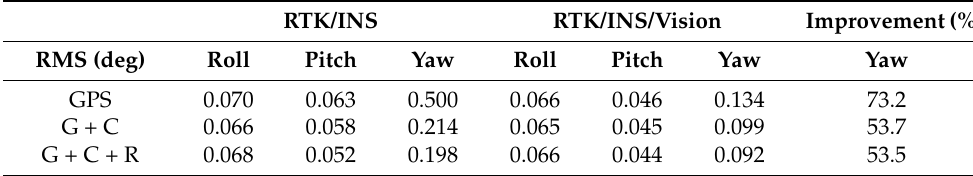
Table 4. RMS of the attitude error of the tightly coupled RTK/INS and RTK/INS/Vision integration for the GPS, GPS + BDS (G+C), and GPS + BDS + GLONASS (G+C+R). RTK/INS RTK/INS/Vision Improvement (%) RMS (deg) Roll Pitch Yaw Roll Pitch Yaw Yaw GPS 0.070 0.063 0.500 0.066 0.046 0.134 73.2 G + C 0.066 0.058 0.214 0.065 0.045 0.099 53.7 G + C + R 0.068 0.052 0.198 0.066 0.044 0.092